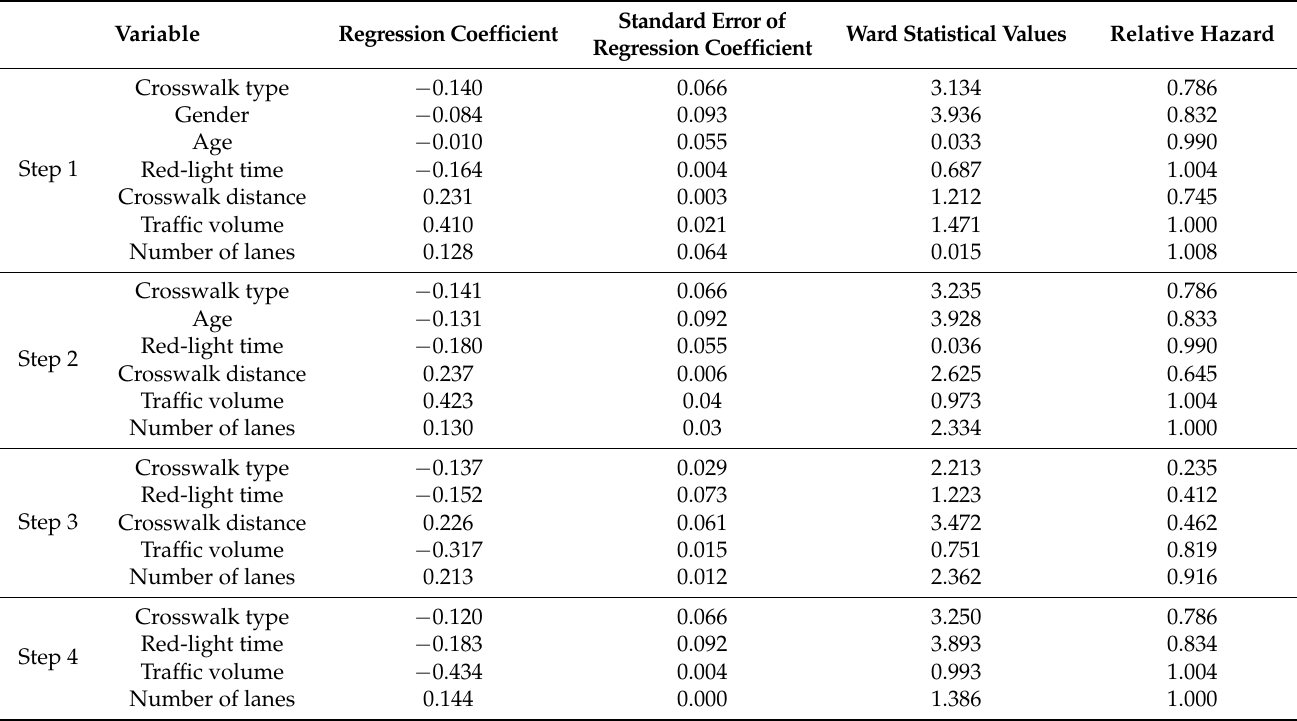
Table 4. Backward elimination step for temporal risk